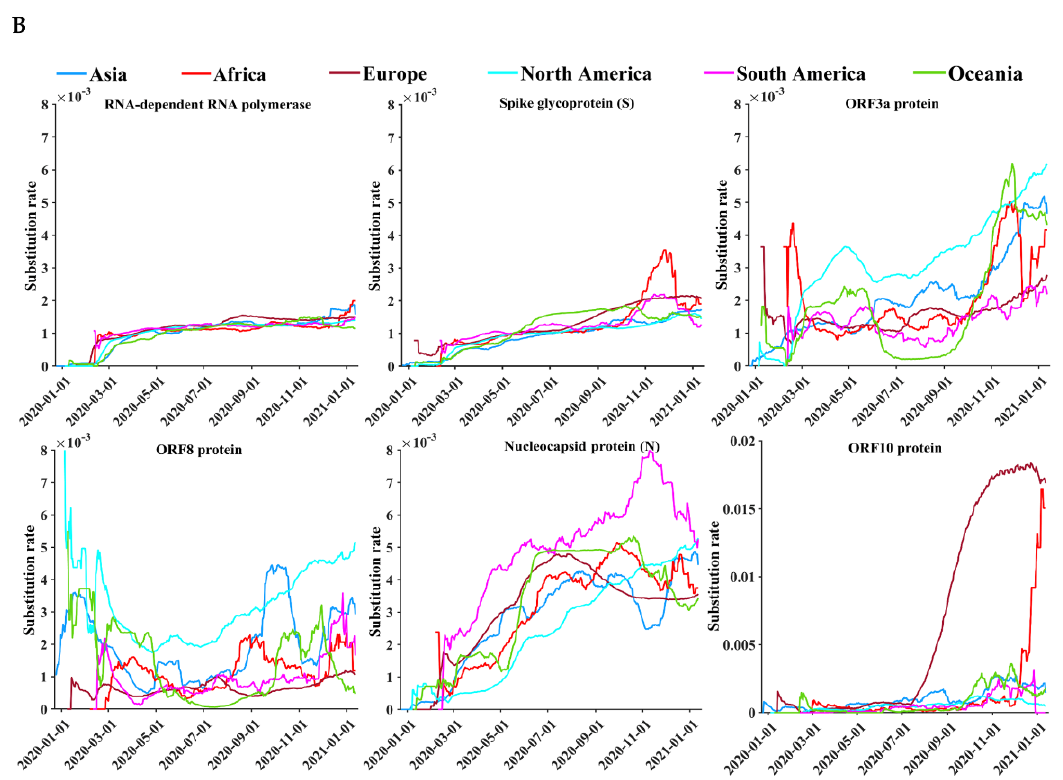
Figure 2. Temporal distributions of the substitution rates of the six SARS-CoV-2 proteins. The proteins were the top six proteins with the highest substitution rates. ( A ) The global substitution rate curves of SARS-CoV-2 proteins based on a time sliding window. ( B ) The substitution rate curves of SARS-CoV-2 proteins based on a time sliding window on different continents. The vertical axis represents the moving-window substitution rate, calculated by dividing the total number of polymorphic sites of a protein contained in the sequences, 15 days before and after a specific date, by the total number of all positions of the protein in the